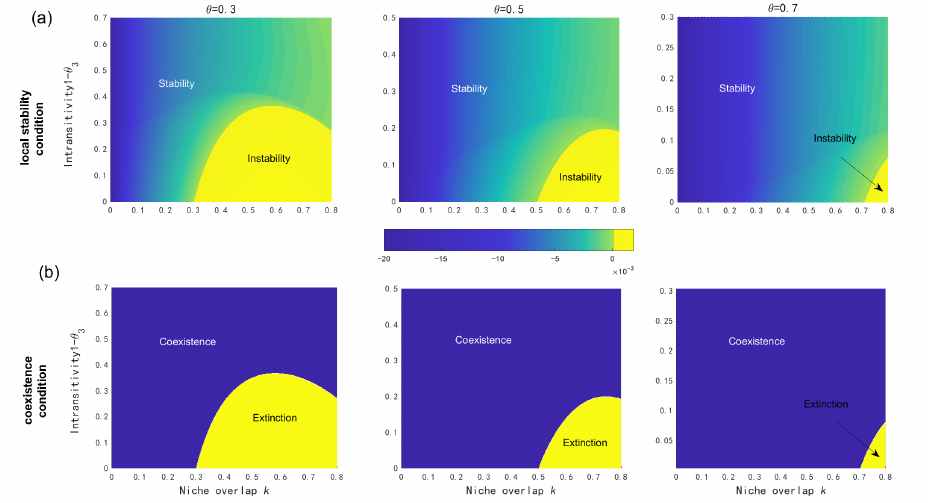
Figure 2. Coexistence area at different levels of competitive symmetry ( θ = 0.3,0.5,0.7). ( a ) Stability analysis results of three species system at nonzero equilibrium point. In the parameter range of Re λ i < 0, nonzero equilibrium point N ∗ would be locally stable. There were two kinds of ranges: i blue and green colors (stable coexistence at N ∗ ), yellow colors (unstable at N ∗ ). ( b ) Final coexistence i i condition, which derived by the intersection of local stability conditions and existence conditions for nonzero equilibrium point N ∗ . The final entire parameter space was still divided into two areas: i coexistence (nonzero equilibrium point N ∗ exist and stable) and extinction (not exist or locally i unstable). Intransitivity 1 − θ 3 was from [ 0, 1 − θ ] . r 1 = r 2 = r 3 = 0.02.